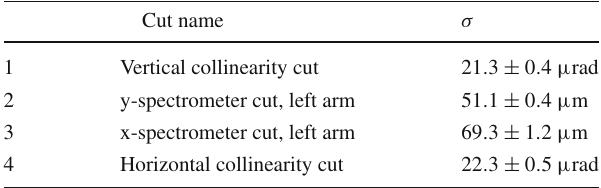
, see also y , no right far